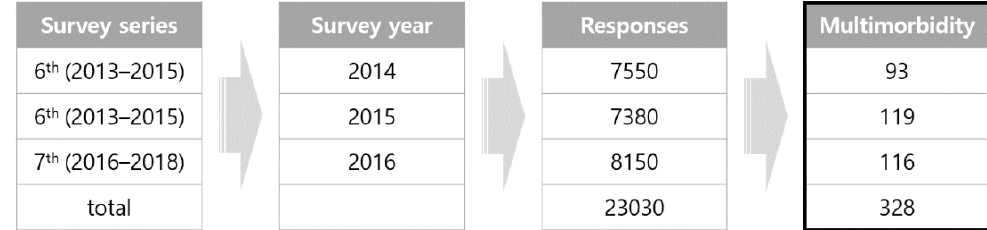
Figure 1. Respondents of patient with multimorbidity ( N = 328) (South Korea, 2014–2016).